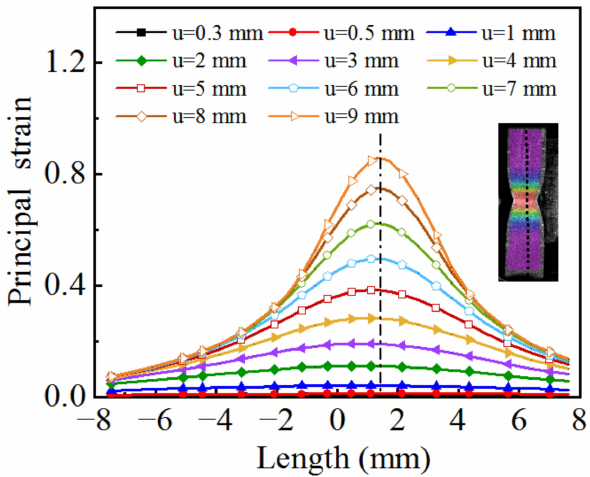
Figure 8. Distribution of principal strain in the longitudinal